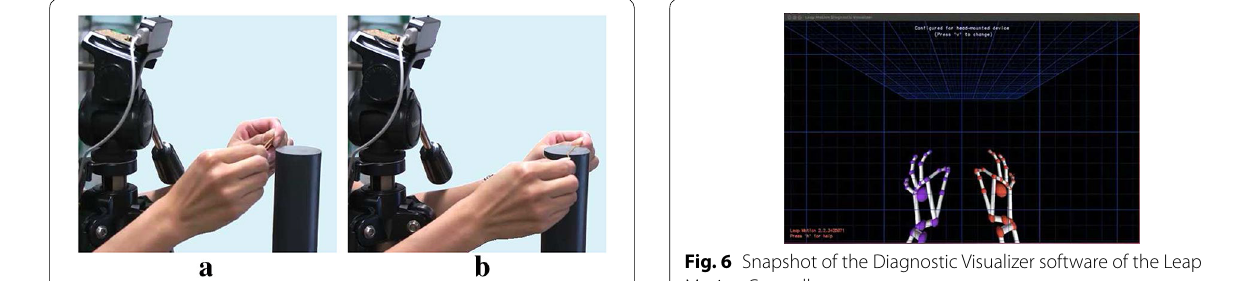
Fig. 5 Tracking of the human hands with the Leap Motion Controller. In a before starting the assembly task and in b during the assembly task